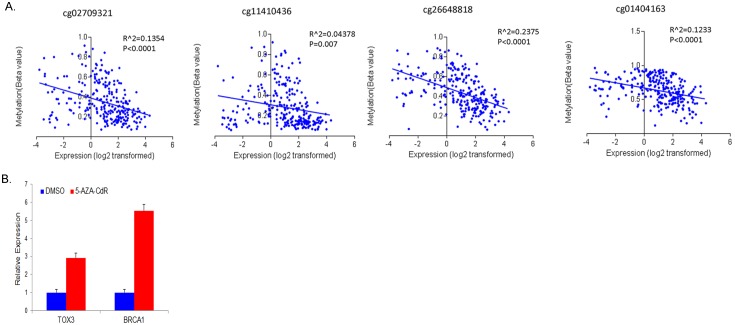
Expression of TOX3 is correlated with the promoter methylation in breast tumors and increased by 5-aza-CdR treatment.(A) TCGA breast invasive carcinoma DNA methylation (Illumina Infinium HumanMethylation450 BeadChip, version 2014-05-02) and gene expression microarray (Agilent 244K, G4502A, version 2013-06-02) datasets were analyzed. Scatter plots show a significant inverse correlation between expression of TOX3 and the promoter methylation at four CpG sites. (B) qRT-PCR results after UACC-3199 cells were treated for four days with 5-aza-CdR. Expression of TOX3 and BRCA1 were significantly increased after treatment.